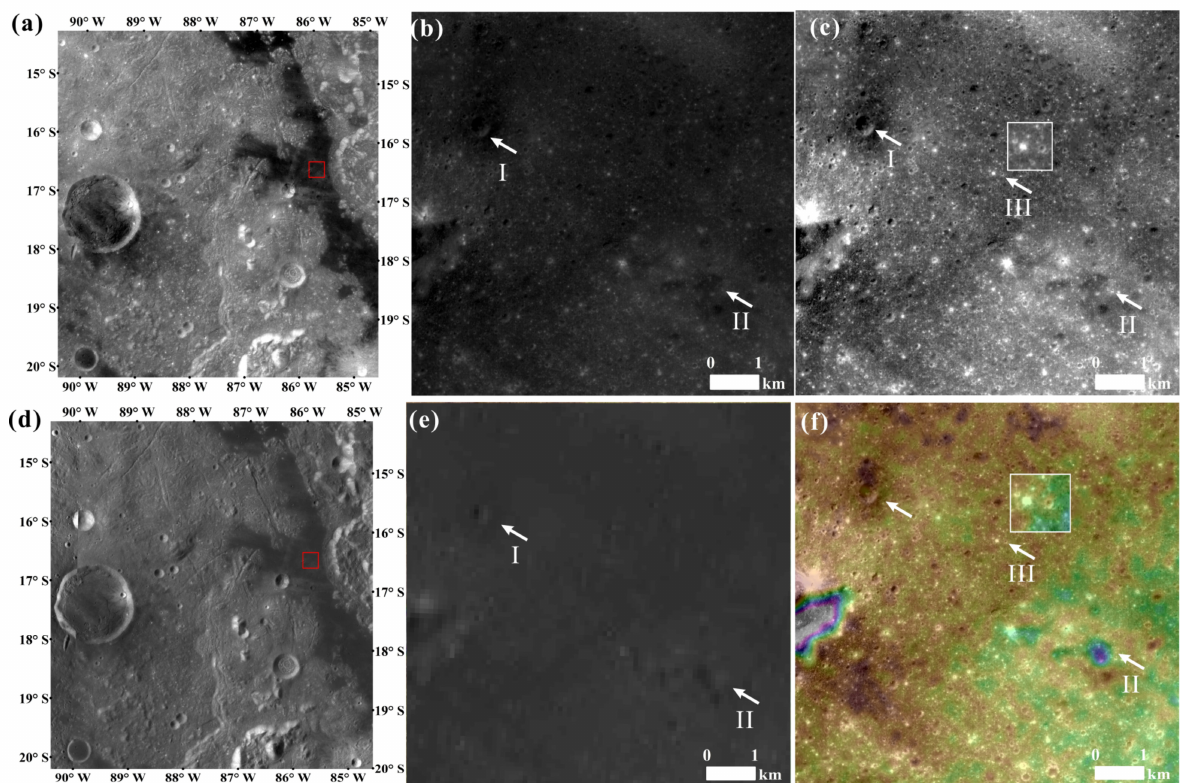
Figure 3. Comparison between CE-2 data with WAC data (108 m/pix): ( a ) 7 m resolution CE-2 CCD images of part of Orientale Basin: CE2_GRAS_DOM_07m_I112_17S088W_A.tif, the red box indicates the location of ( b , c , e , f ); ( b ) original 7 m resolution CE-2 CCD image of the red box area in a and d; ( c ) the 7 m resolution CE-2 CCD image of the red box area in a and d after partial stretching, the white box area is the enlarged image of the area indicated by the white arrow III; ( d ) WAC (108 m/pix) of part of Orientale Basin, the red box indicate the location of ( b , c , e , f ); ( e ) WAC image of the red box area in a and d after partial stretching; ( f ) the 7 m resolution CE-2 CCD data superimposed on 20 m-resolution CE-2 DTMs of the red box area in a and d, the white box area is the enlarged image of the area indicated by the white arrow